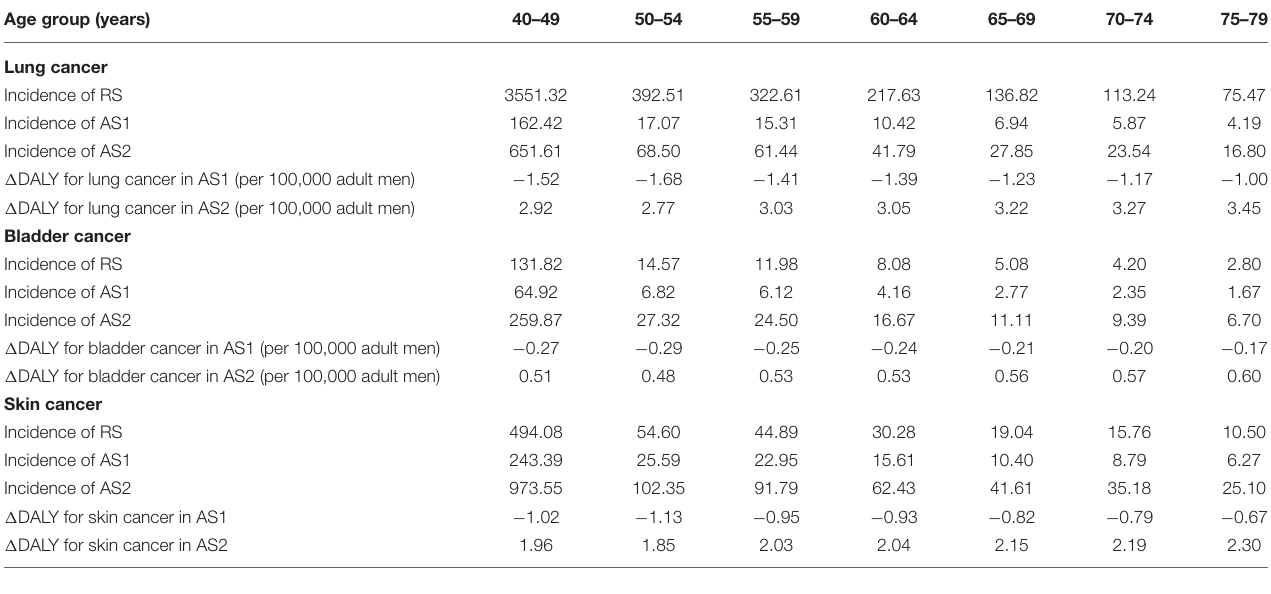
TABLE 6 | Estimated net health impact ( 1 DALY) associated with the intake of inorganic arsenic through the consumption of rice in alternative scenarios 1 and 2 in different age groups.